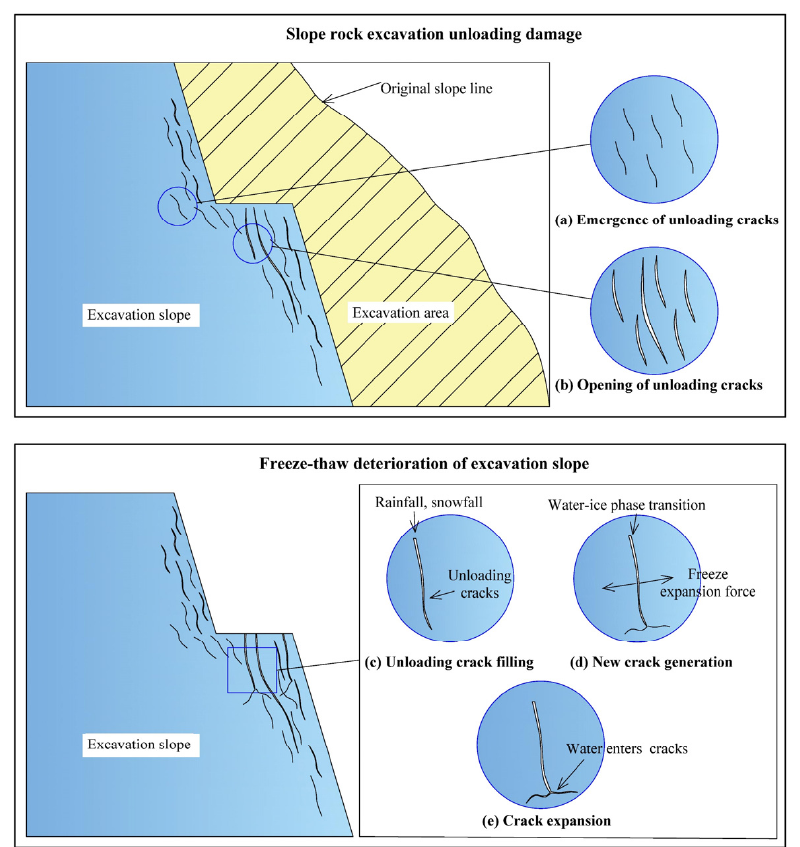
Figure 1. Schematic diagram of the successive effects of slope excavation unloading and freeze-thaw deterioration.